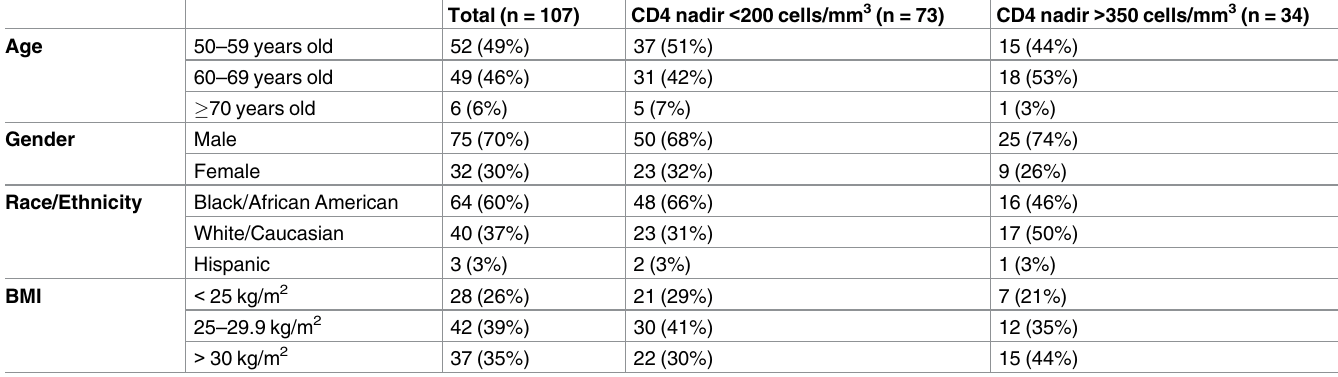
Table 1. Overall demographics and clinical